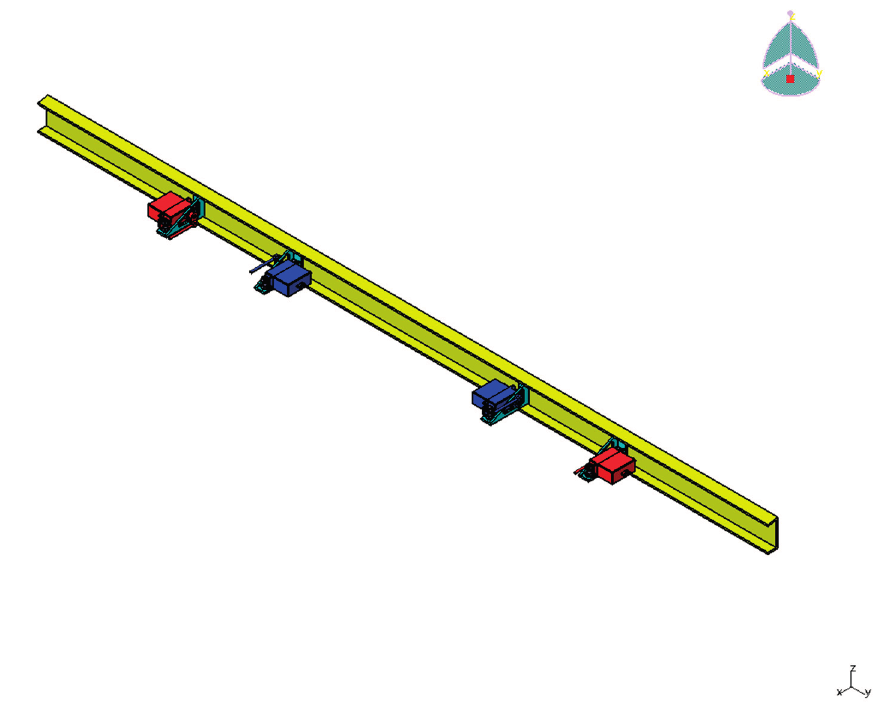
Figure 7. Isometric view of servo actuators in a four servo actuator configuration.